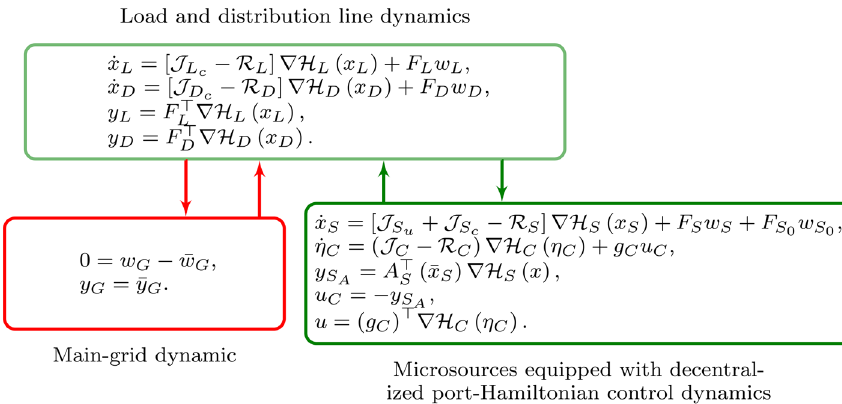
Fig. 7 Overall microgrid dynamic in grid-connected mode: microsources equipped with decentralized port-Hamiltonian control